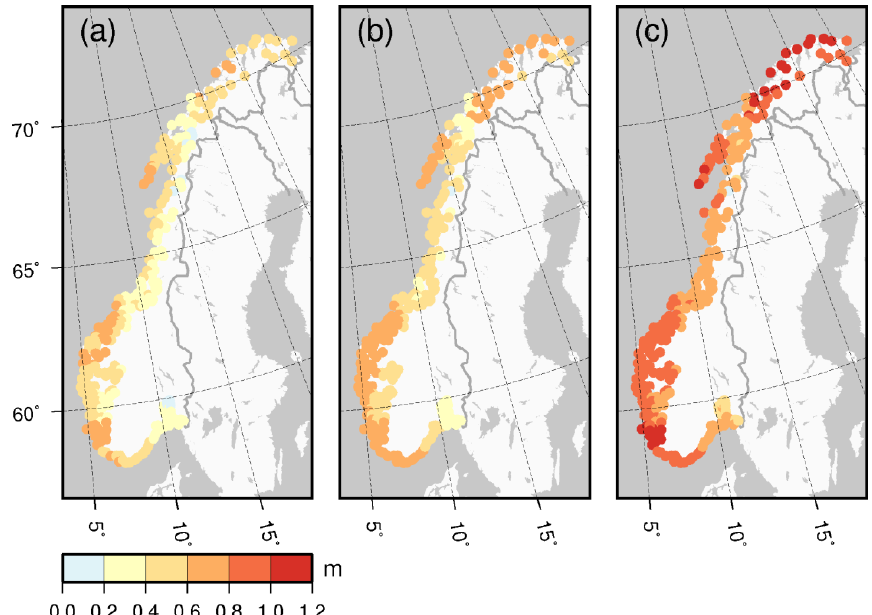
Figure 15. Allowances (m) for the 290 coastal municipalities in Norway calculated using the 200-year return heights and projected RSL change over the period 1986–2005 to 2081–2100 for: ( a ) RCP2.6; ( b ) RCP4.5; and ( c ) RCP8.5. We assume that the model range corresponds to the 17% to 83% probability bounds and fit a normal